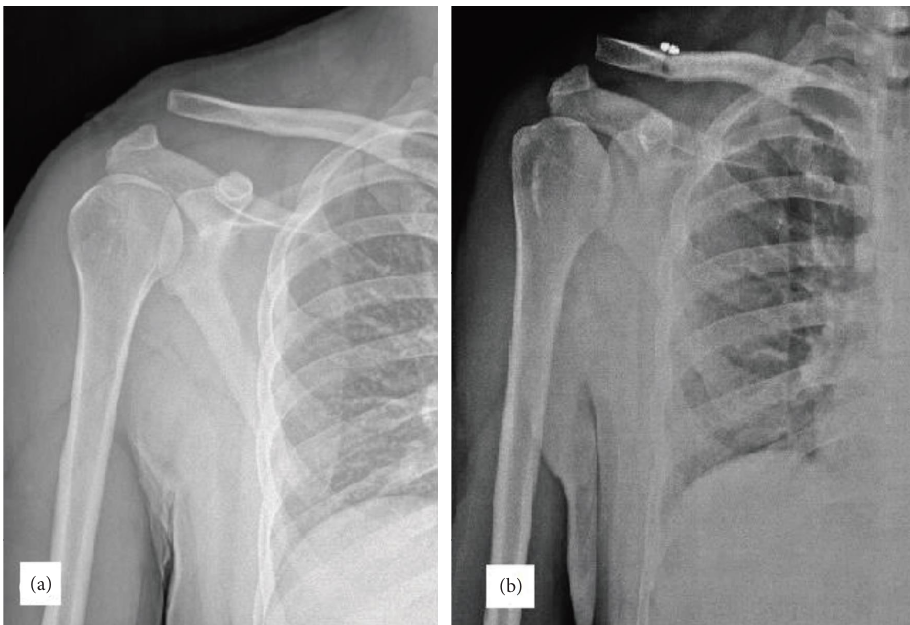
Figure 5: Serial radiographs of a 36-year-old man treated with a minimally invasive TightRope system. (a) Preoperative anterior-posterior radiograph showing type III AC dislocation. (b) 1-month postoperative follow-up with reduction